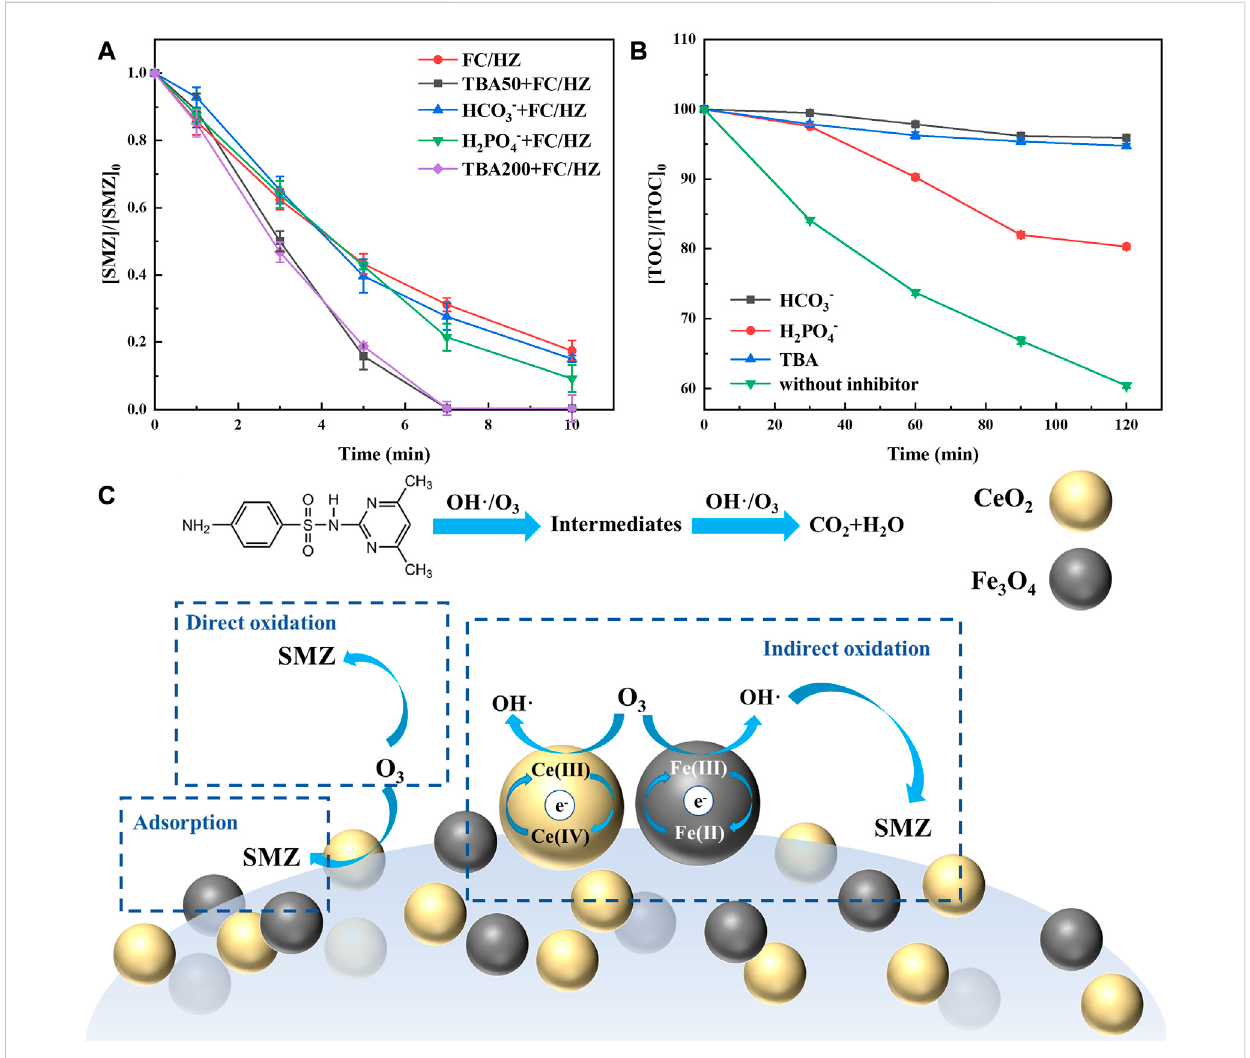
FIGURE 3 (A) and (B) showtheeffectofscavengersonSMZdegradationef fi ciencyandTOCremovalef fi ciency. (C) ProposedmechanismoftheFC/HZcatalyst in the catalytic ozonation